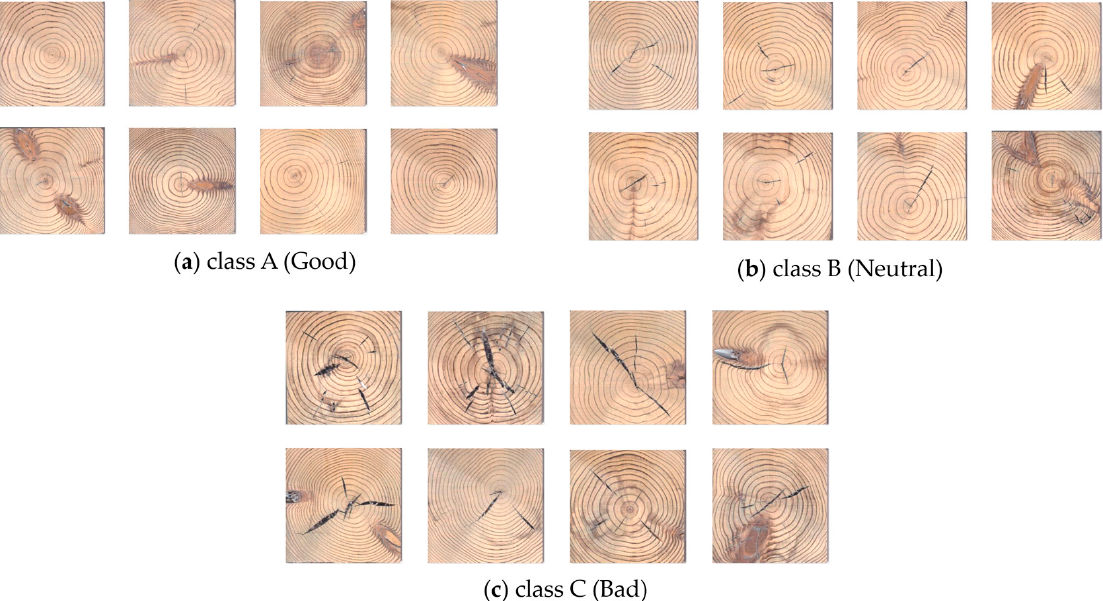
Figure 5. Scenes for timber processing and image acquisition. ( a ) Cutting scene of square timber; ( b ) Image of the cross-section is scanned using a scanner.